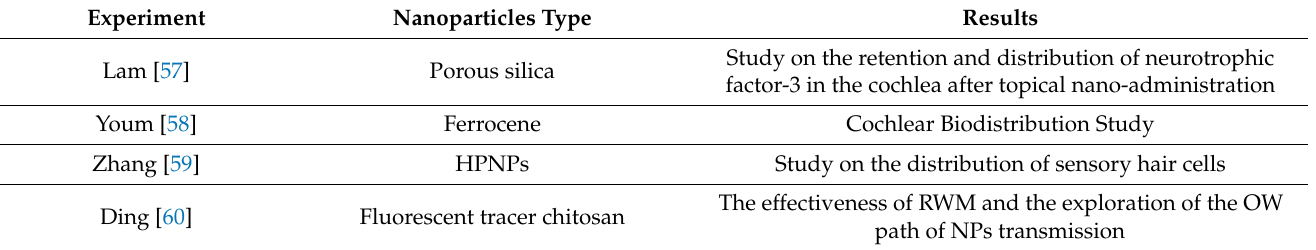
Table 7. Nanoparticles tracing